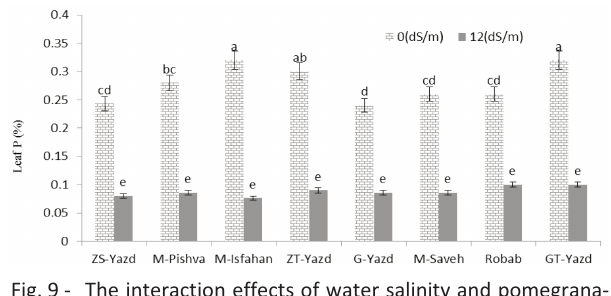
Fig. 9 ­ The interaction effects of water salinity and pomegrana­ te cultivars on leaf phosphor content.